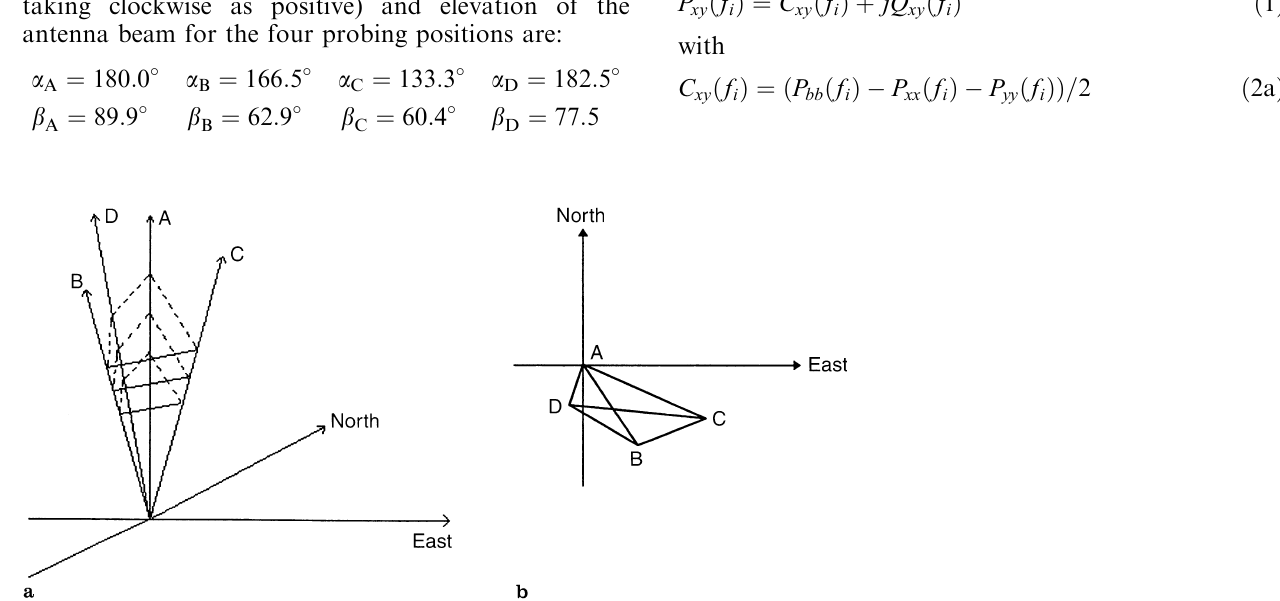
Fig. 1a, b. Illustration of the EISCAT CP2 mode: a the four probing directions of the antenna beam during CP2; b geometric configuration of the four probing positions in a plane at a